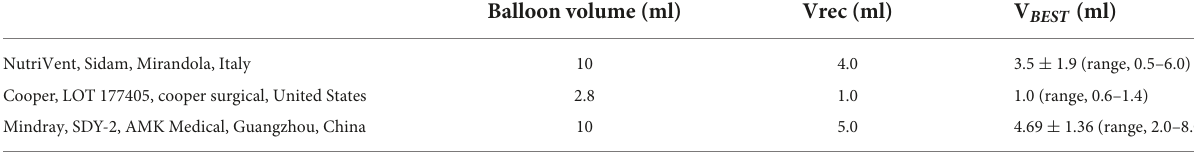
TABLE 2 Balloon filling volumes in different esophageal catheters.